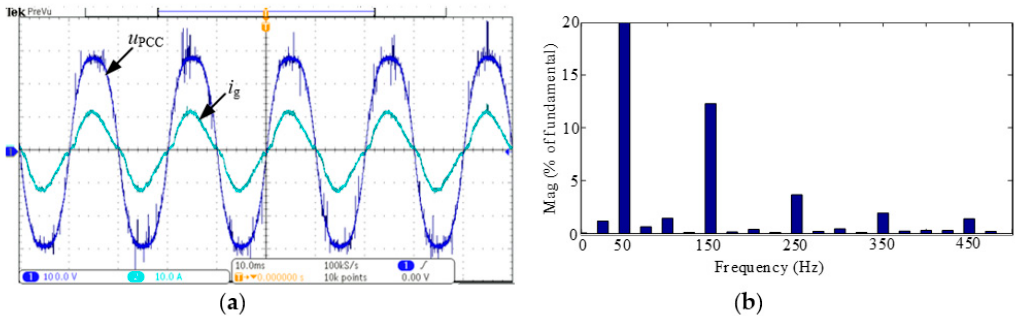
Figure 19. The experimental results of conventional dual-loop control strategy. ( a ) Waveforms of grid voltage and current. ( b ) The FFT analysis of grid current (THD = 13.17%).